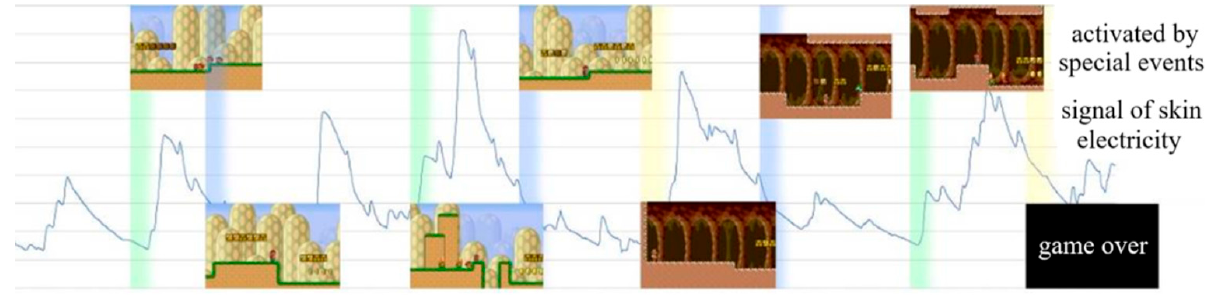
Figure 5. Two approaches of emotion judgment.